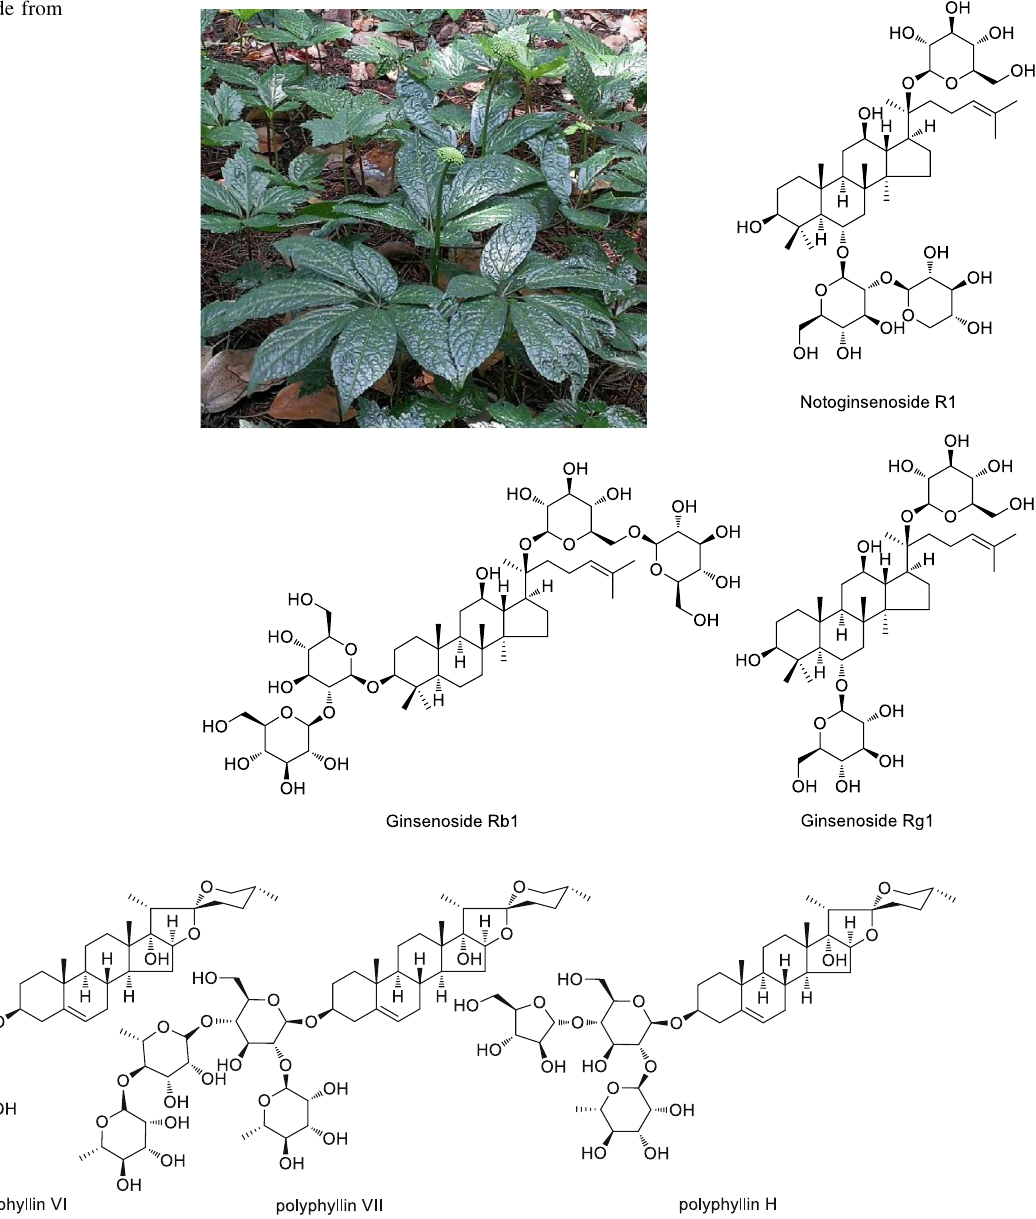
Fig. 5 Main bioactive components of polyphyllin VI, VII and H from the rhizome of